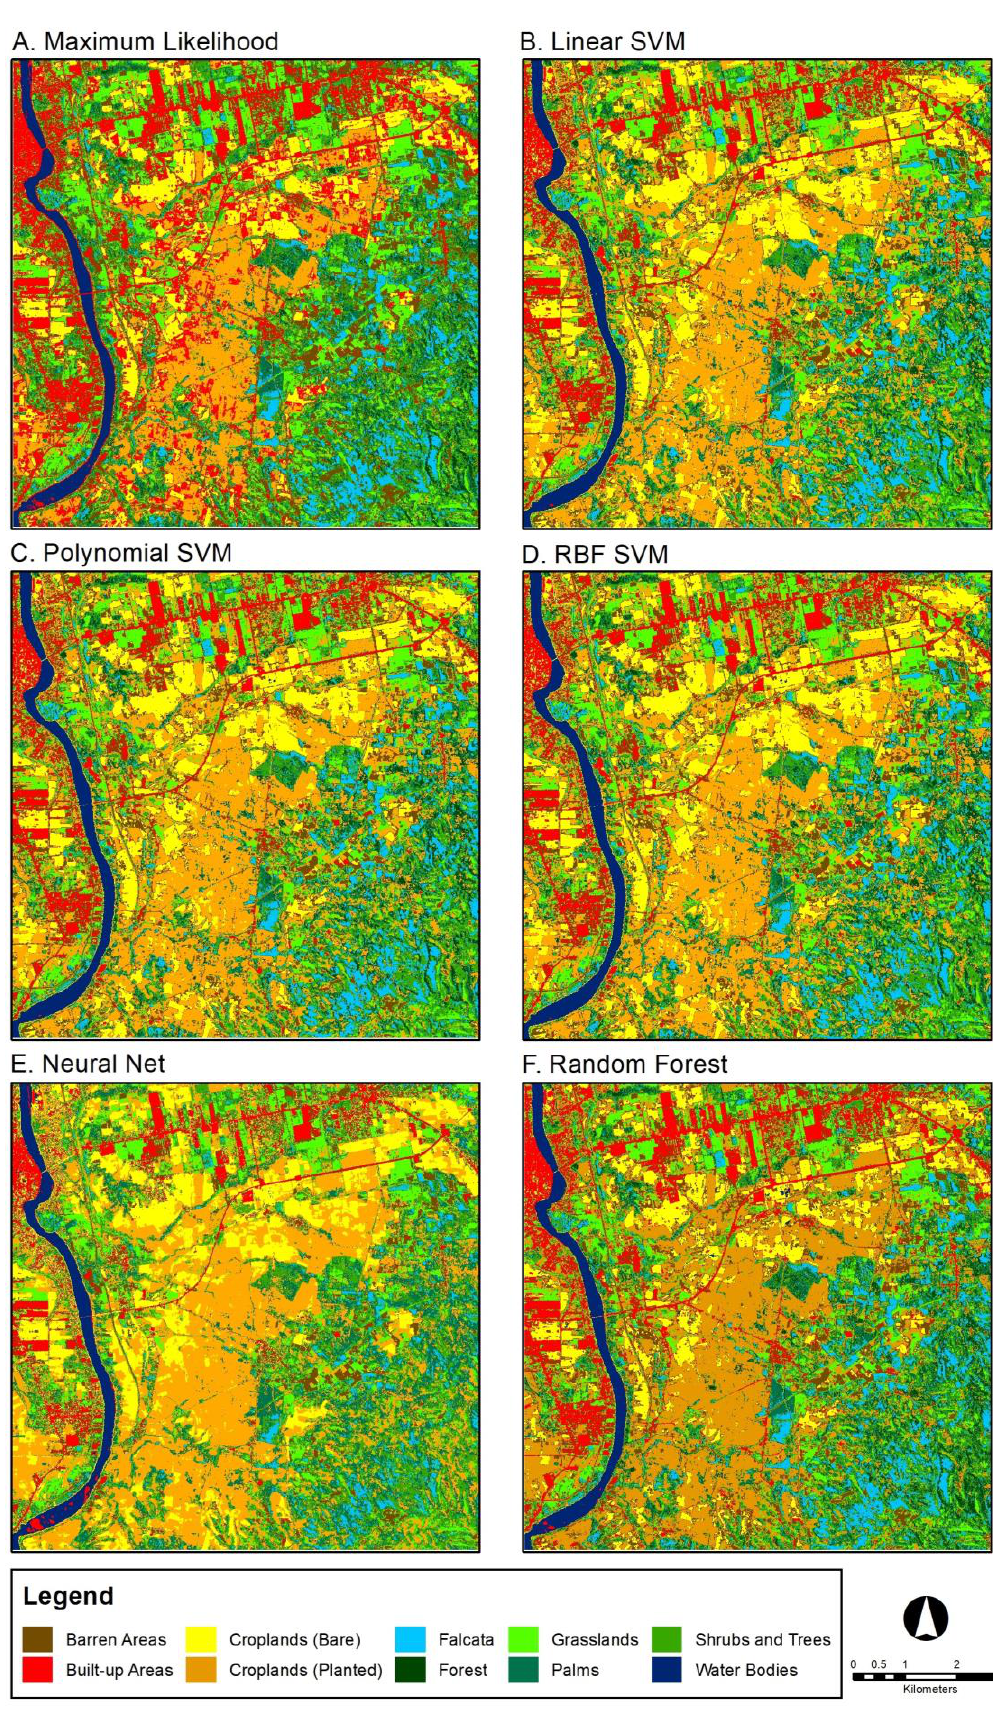
Figure 2 . Sentinel-2 10-m resolution classification